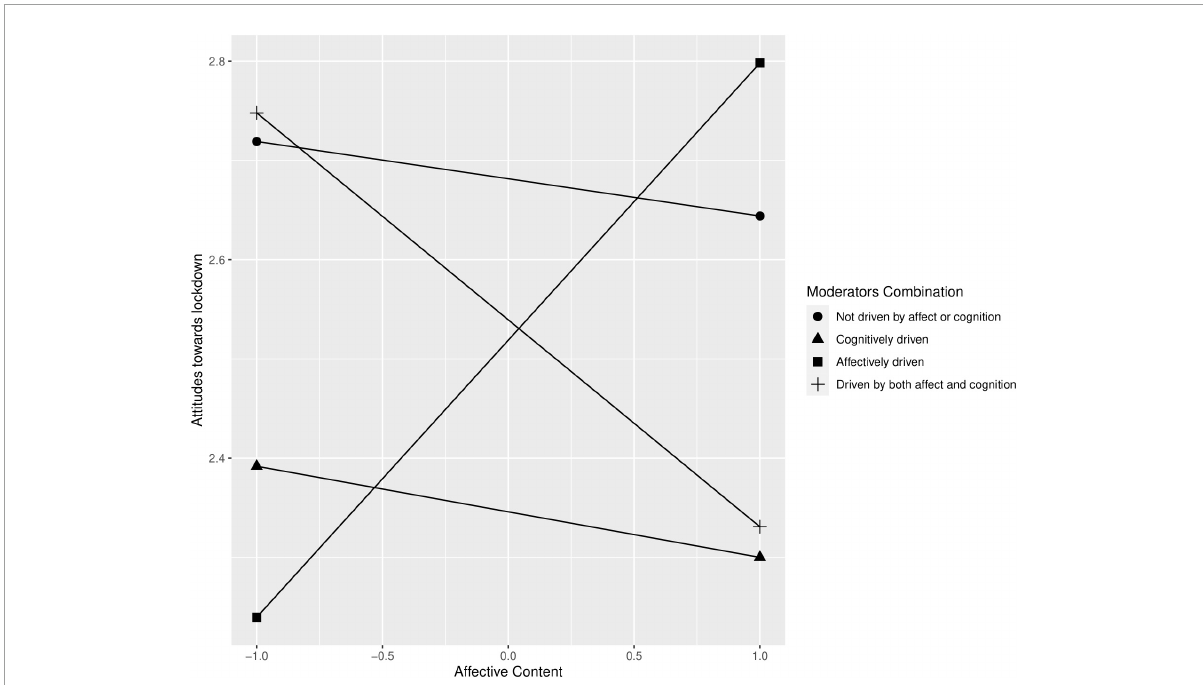
FIGURE1 Moderating effect of need for affect (NFA), need for cognition (NFC), and valence of affective contents on attitude toward